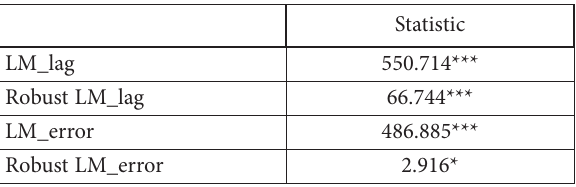
Table 4. Statistical tests results for form selection